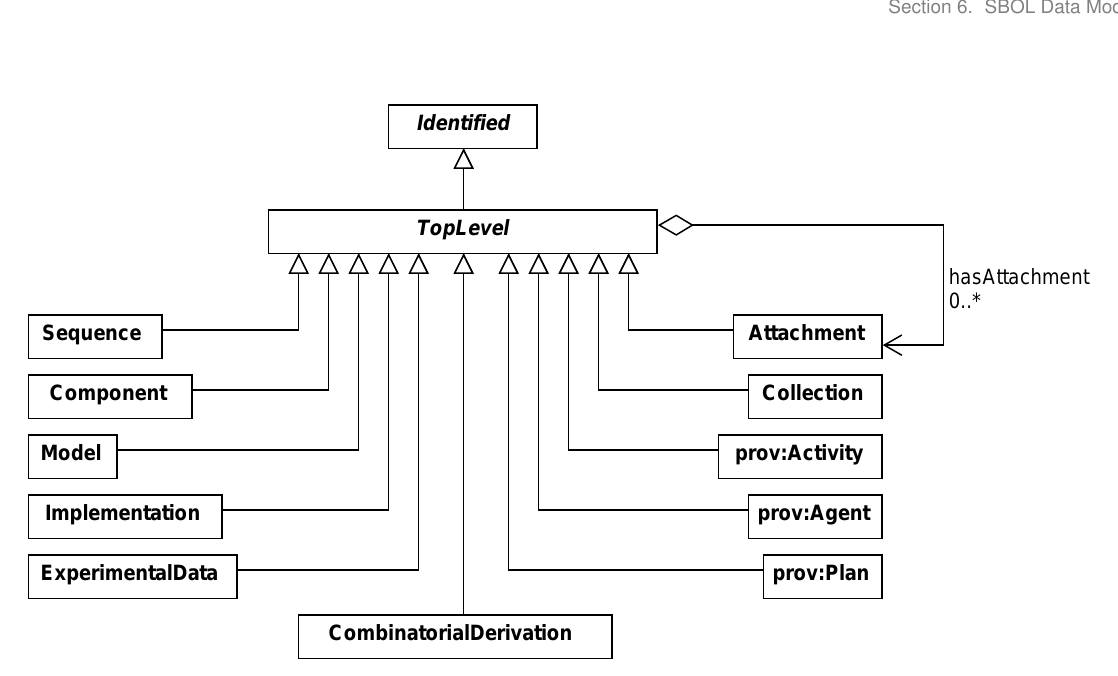
Figure 6: Classes that inherit from the TopLevel abstract class.